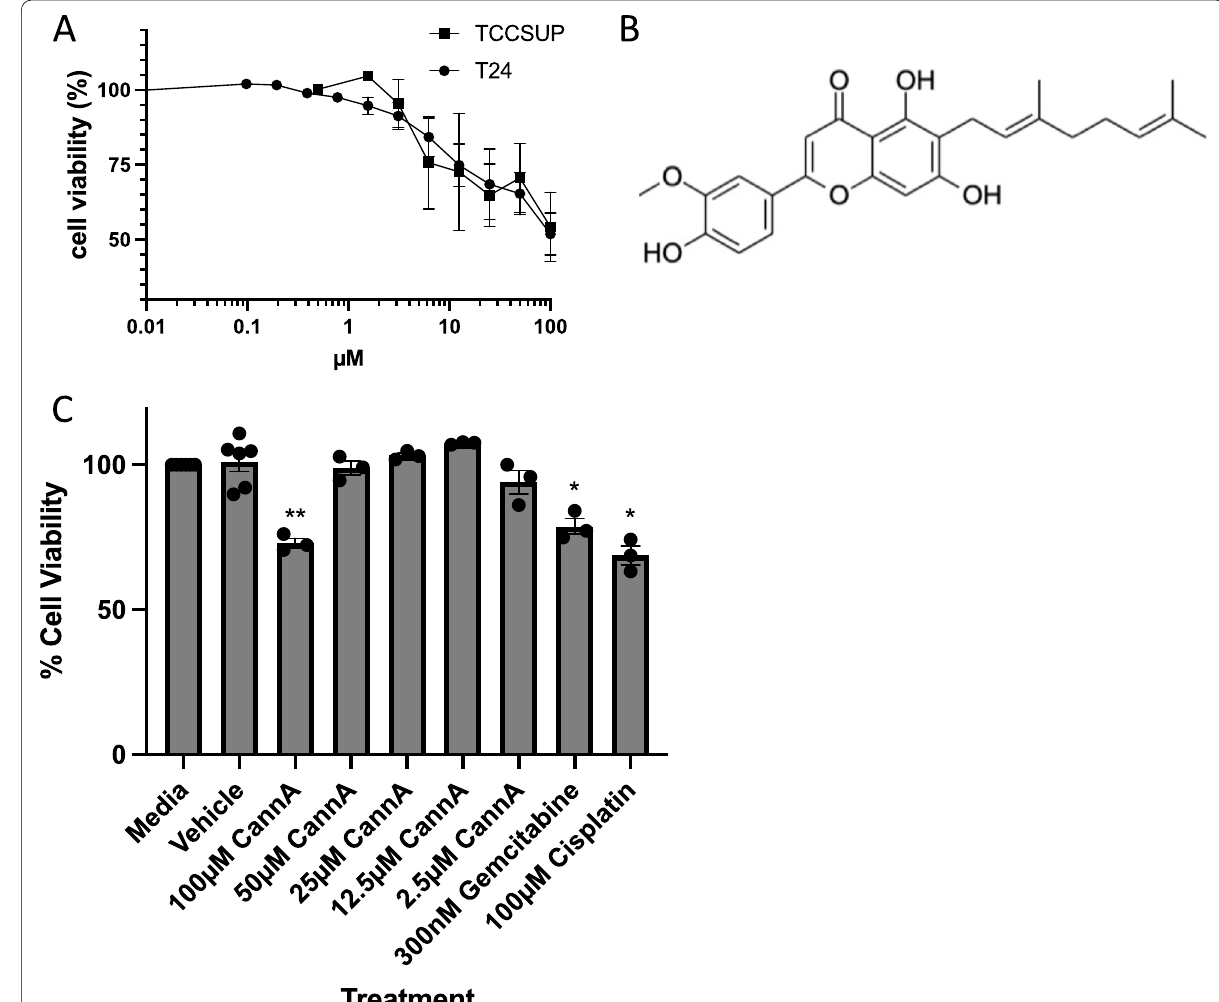
Fig. 2 Effects of cannflavin A on cell viability. A Cell viability was assessed after 48-h treatment with cannflavin A in T24 and TCCSUP cells. The results from Fig. 1A in T24 cells were used to compare with the TCCSUP cell line. The results indicate that both transitional cell carcinomas are sensitive to cannflavin A in a similar fashion. B Schematic representation of the structure of cannflavin A. C Effects of cannflavin A on the viability of primary bladder epithelial cells. The results indicate that cannflavin A becomes cytotoxic at a concentration of 100 μM, but concentrations below this level are not cytotoxic. Results are